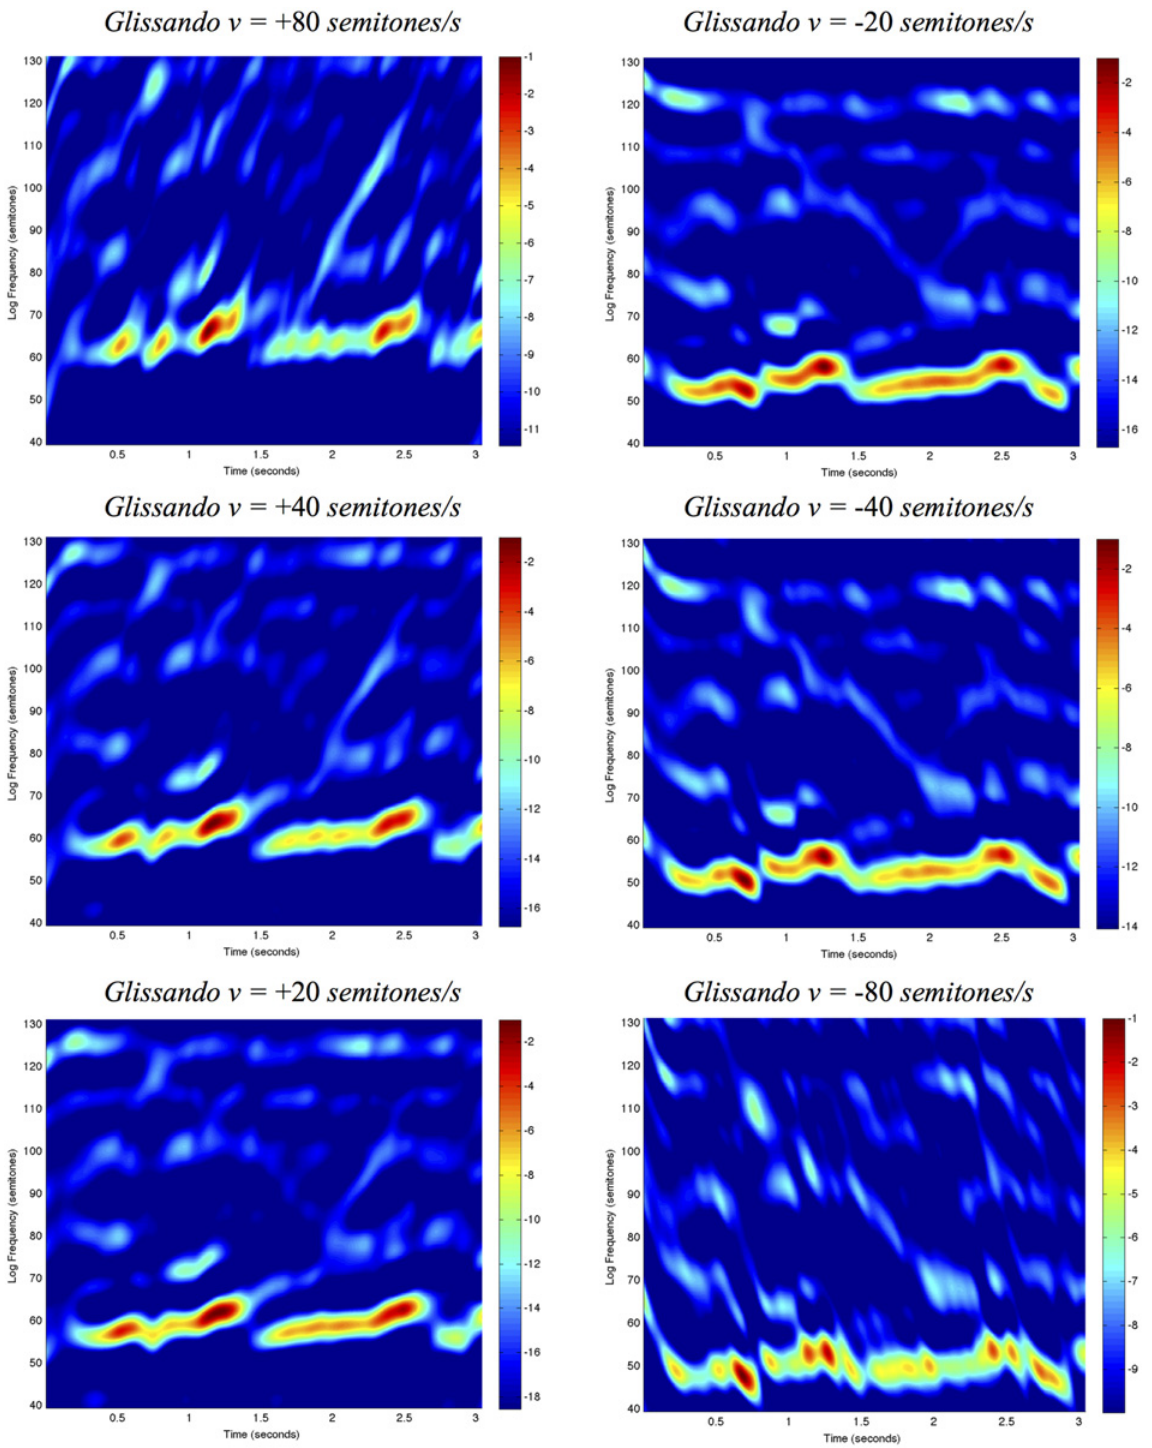
Fig 13. Enhancement of the formants using glissando-adapted receptive fields corresponding to second-order derivatives with respect to logarithmic frequency ν for different glissando values v = +80, +40, 20, -20, -40 and -80 and applied to the first 3 seconds of “ Tom ’ s diner ” computed with time-causal receptive fields at temporal scale σ t = 20 ms and logspectral scale σ ν = 4 semitones (compare with fig. 12 that shows corresponding results for non-adapted separable receptive fields). Note how the formant variations for different amounts of glissando are enhanced by glissando-adapted receptive fields for corresponding values of the glissando parameter. Such a set of glissando-adapted receptive fields for a logarithmic